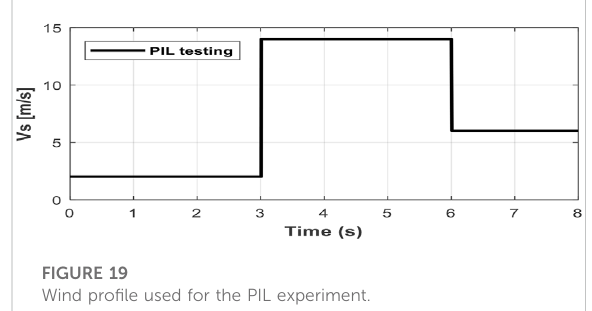
FIGURE 19 Wind pro fi le used for the PIL experiment.